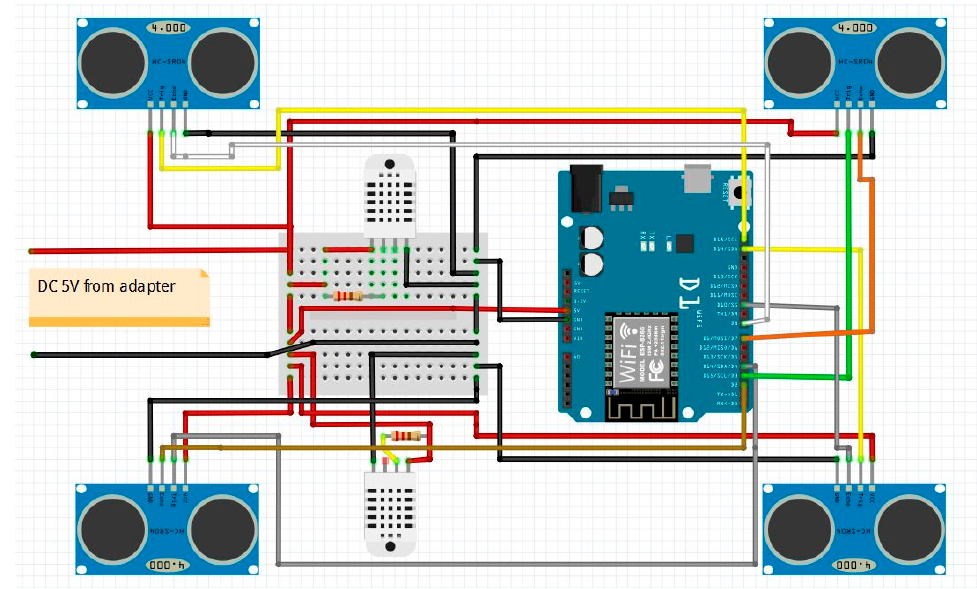
Figure 4. Schematic diagram of the proposed monitoring system.